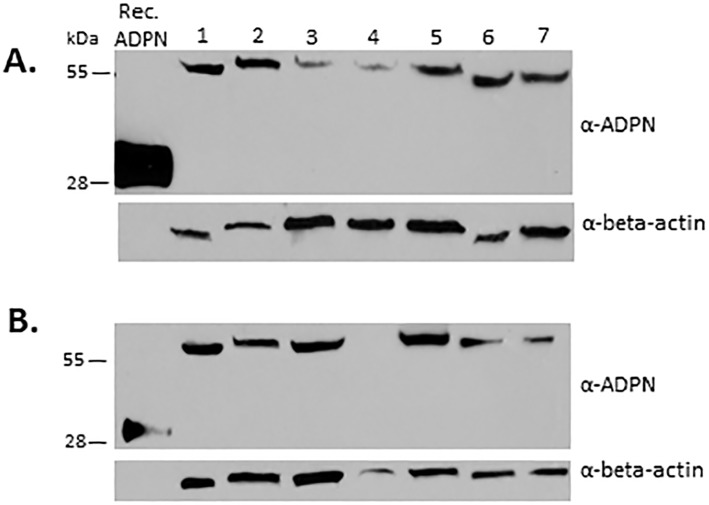
Visceral adipose tissue (VAT) (A) and subcutaneous adipose tissue (SAT) (B) tissue homogenates (50 μg protein) were separated by 15% SDS-PAGE and transferred to nitrocellulose membranes for immunoblot analyses.Adiponectin (ADPN) levels from paired SAT and VAT samples are shown for 7 different subjects. Beta-actin loading control and monomeric recombinant adiponectin (~30 kDa) are shown).